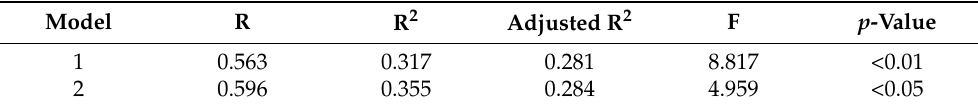
Table 6. A stepwise multiple regression to estimate the association between integration, cognitive ability, and T2. Model R